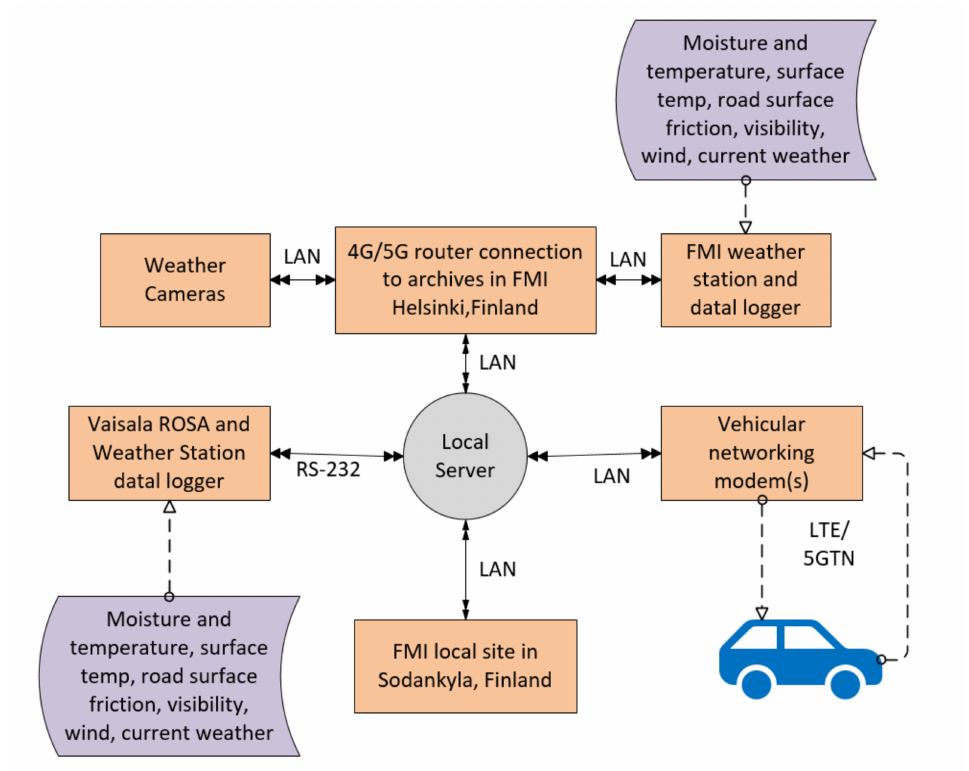
Figure 6. V2V and V2I communication entities.